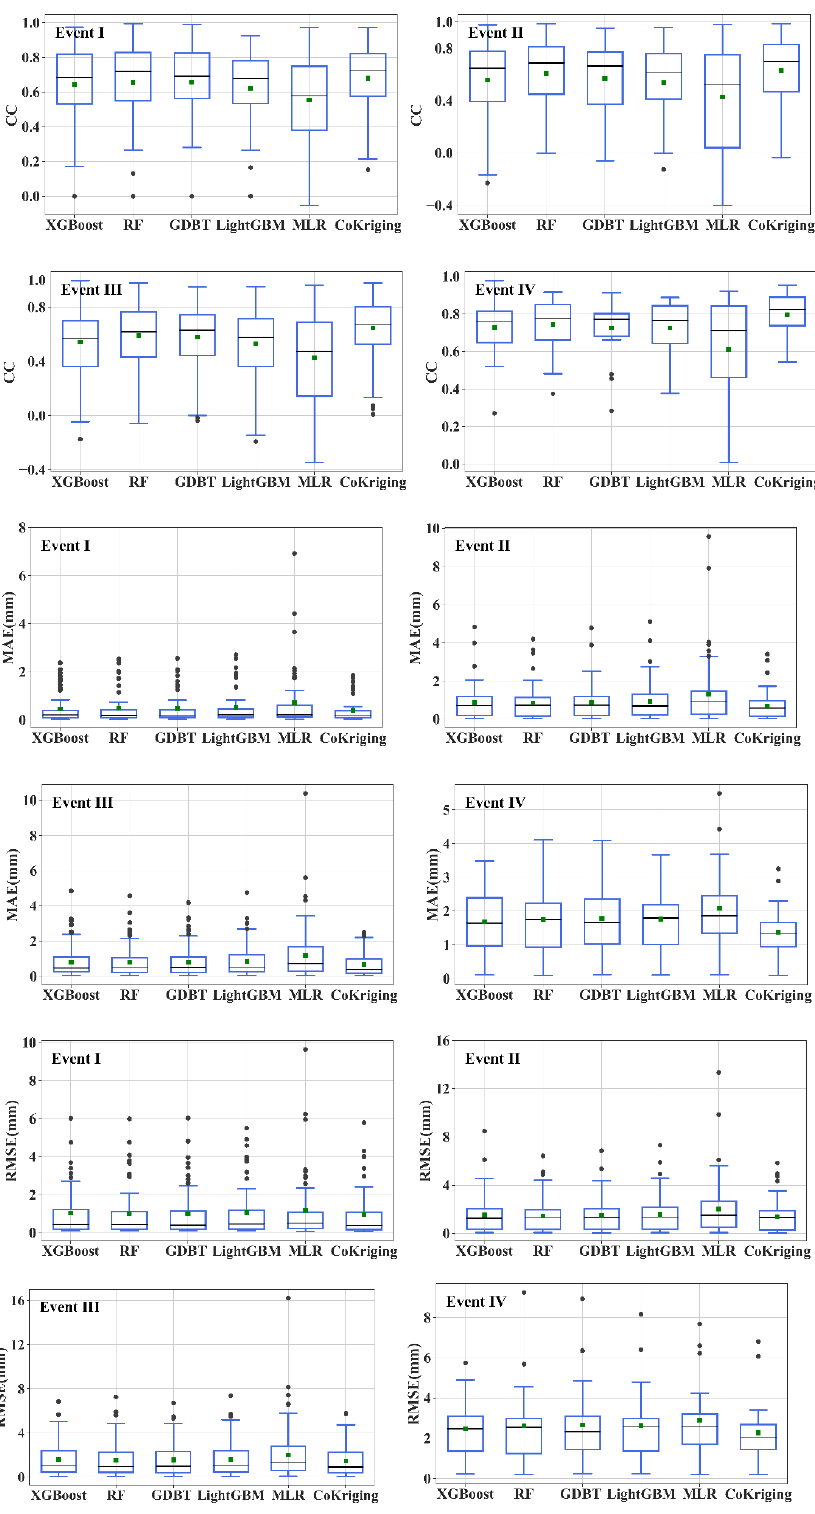
Figure 7. Boxplots of the evaluation indices for the four heavy rainfall events: event I, 23–27 April; event II, 7-10 May; event III, 26-30 August ; and event IV, 16 and 17 September.